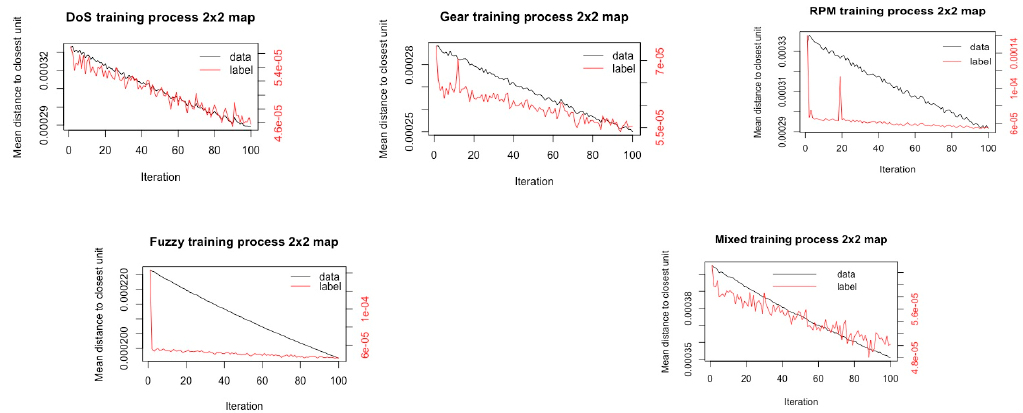
Figure 11. XYF Kohonen network training process for the 2 × 2 maps.